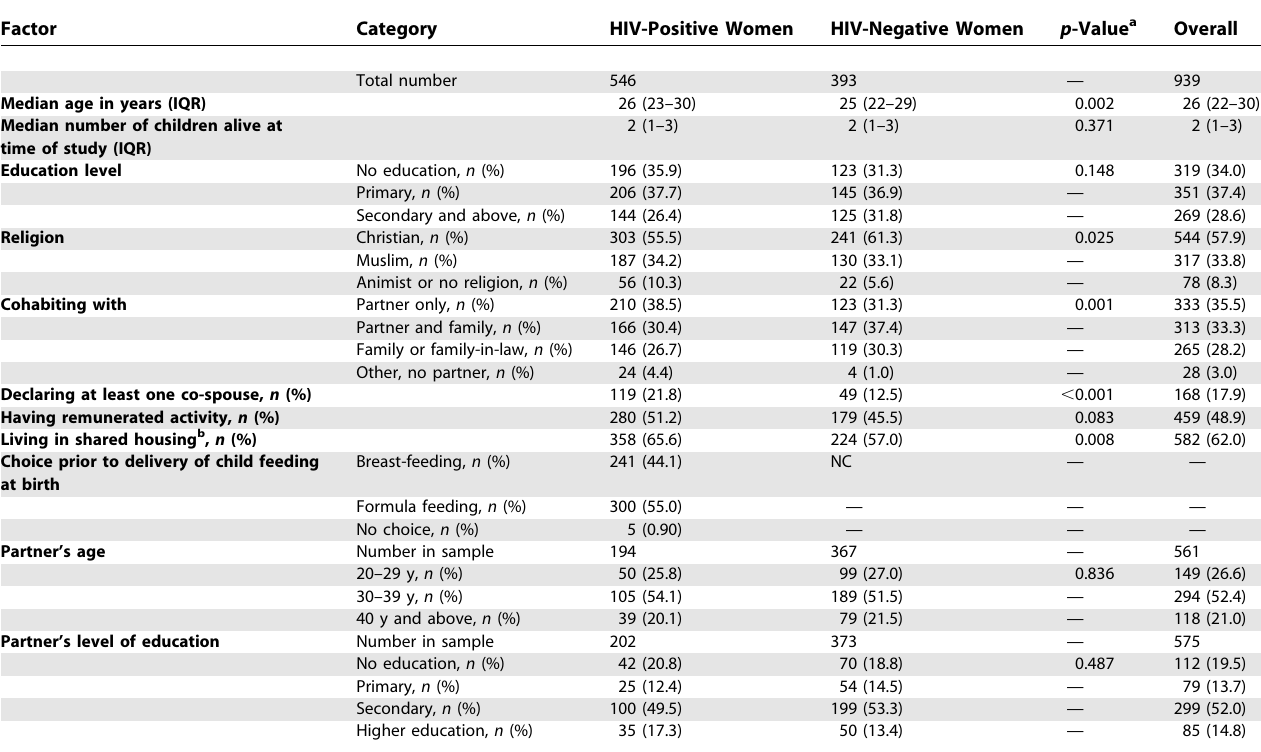
Table 1. Sociodemographic Characteristics of Women at Enrolment According to Their HIV Status (Ditrame Plus ANRS 1201-1202-1253, Abidjan,